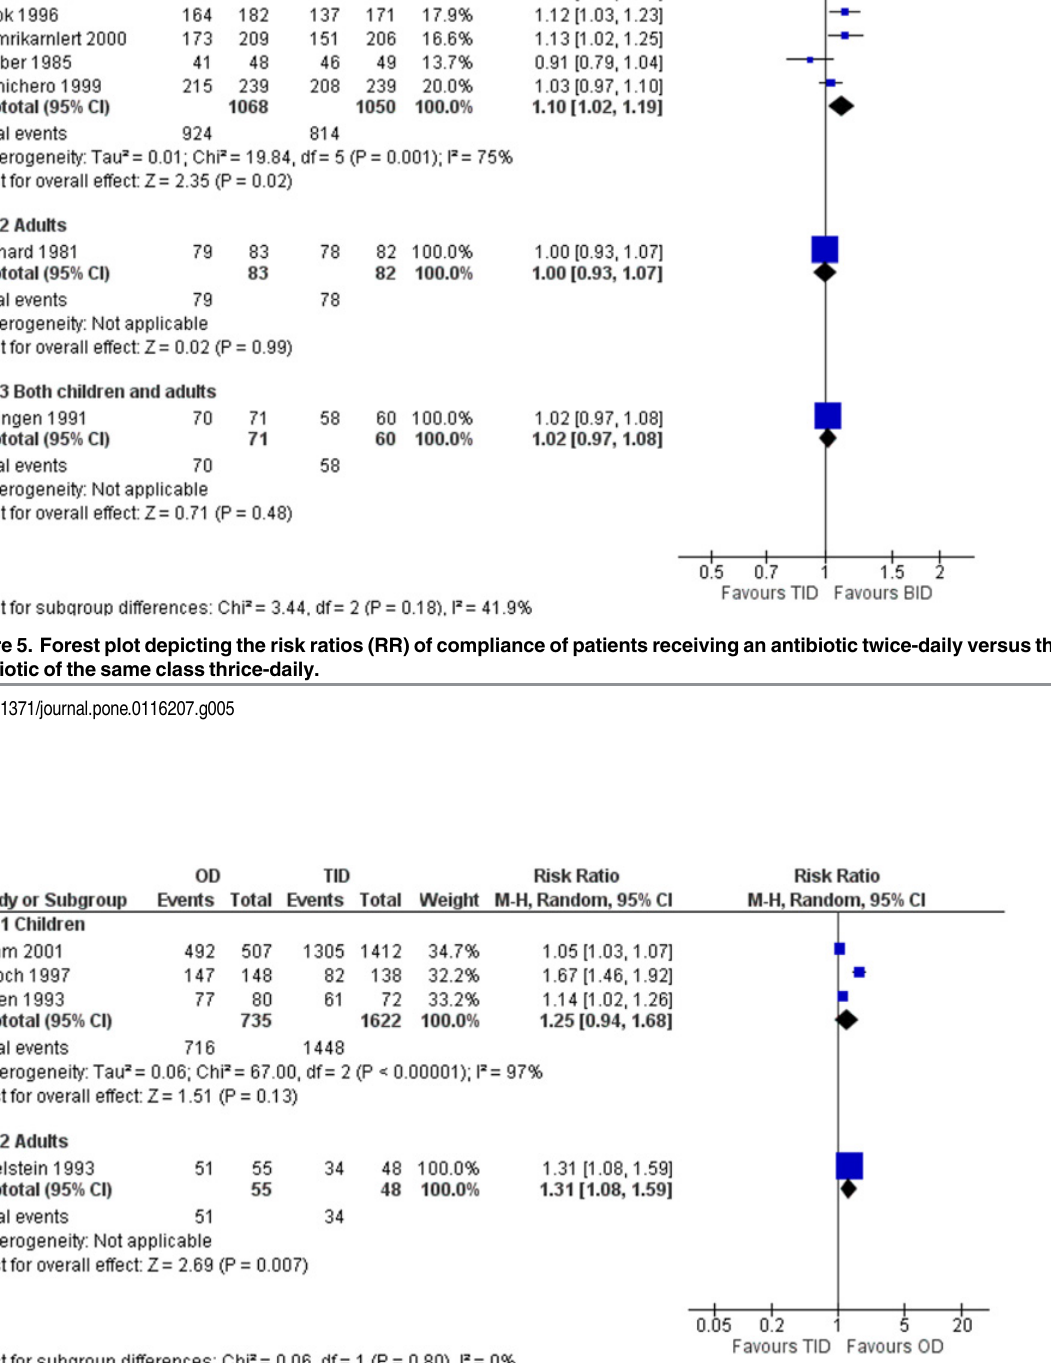
Figure 6. Forest plot depicting the risk ratios (RR) of compliance of patients receiving an antibiotic once-daily versus an antibiotic of the same broad class thrice-daily.